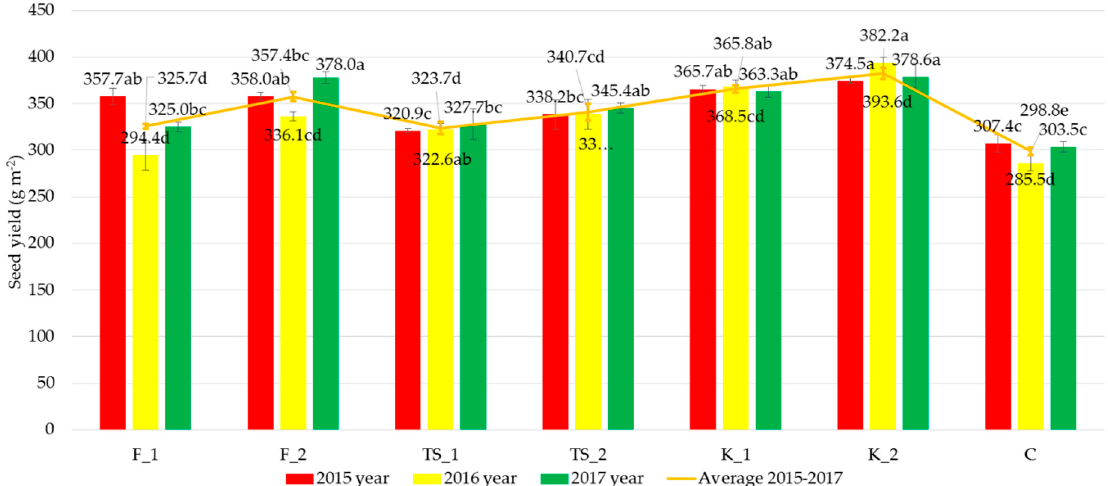
Figure 2. Effect of Fylloton, Terra Sorb Complex, and Kelpak biostimulant treatment on the weight of one thousand seeds of bean variety Oczko. Abbreviations: F_1, single spraying of Fylloton; F_2, double spraying of Fylloton; TS_1, single spraying of Terra Sorb Complex; TS_2, double spraying of